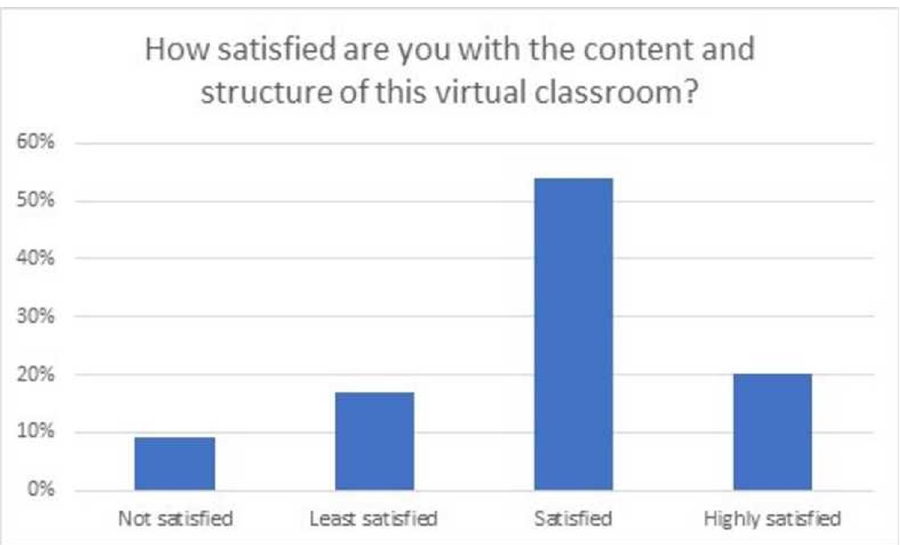
Fig 3. Survey responses regarding overall satisfaction of students with the developed